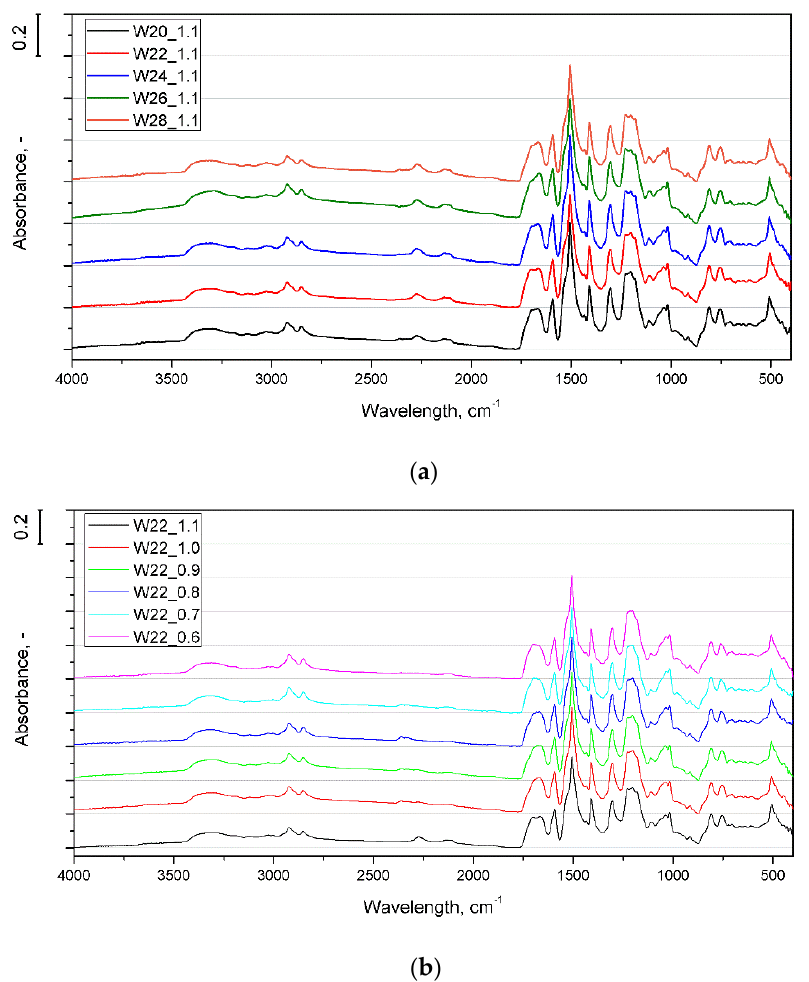
Figure 2. FTIR spectra of PUR foams obtained with different amounts of water ( a ) and different NCO indices ( b ).